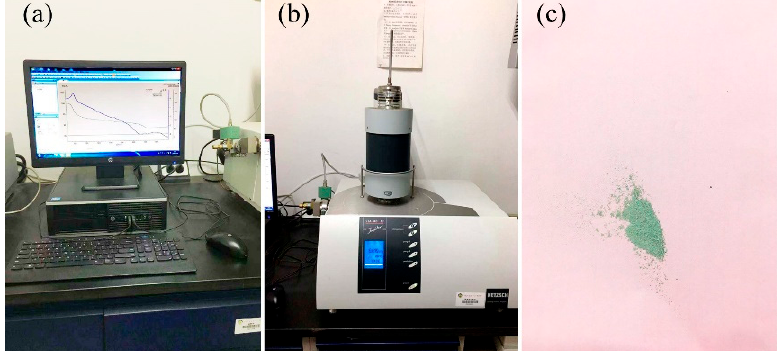
Figure 3. STA449F3 and samples. ( a ) The experiment bench; ( b ) the thermal gravity (TG) analyzer; ( c ) the samples.